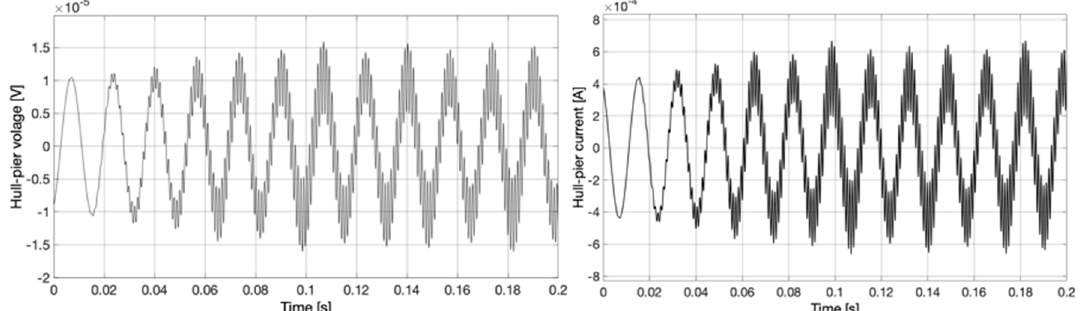
Figure 10. Simulink Model #1 numerical experiments results for asymmetrical shore cables of 100 m in length and hull capacitances (0.030, 0.028, 0.033 μ F), symmetrical supply voltages and stray current path resistance equaling 0.024 ohms. Hull—pier voltage ( left ), stray current waveform ( right ).